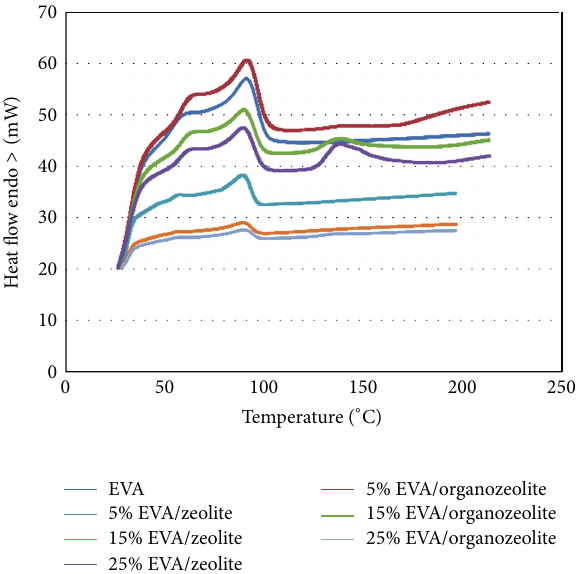
Figure 8: TGA curves of zeolite and organozeolite EVA composites.